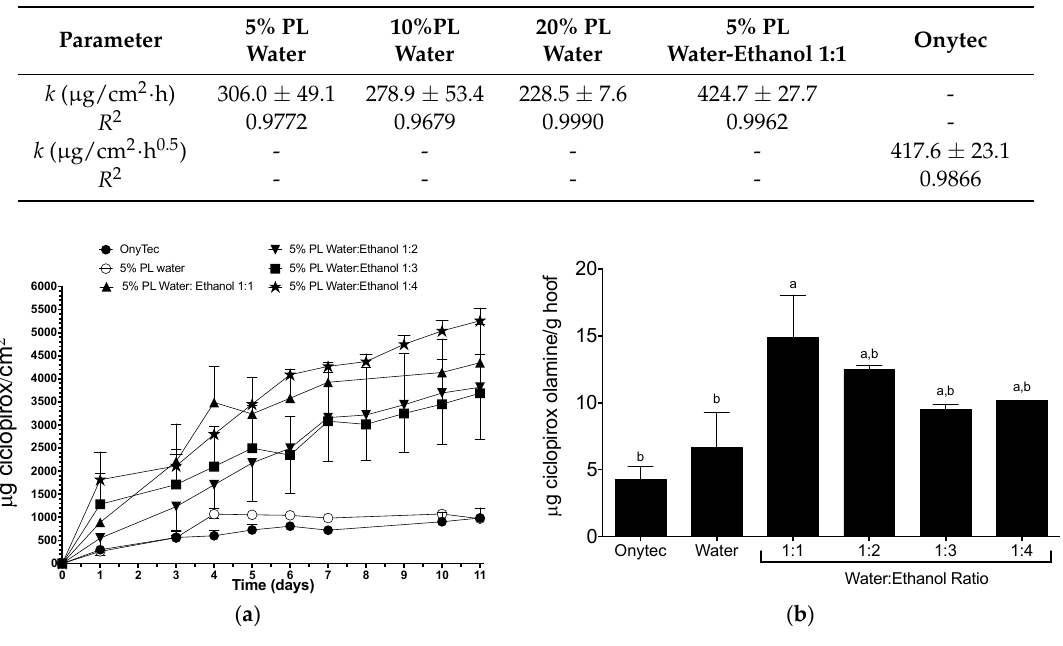
Figure 7. ( a ) Cumulative permeation (mean ± SD, n = 3) of ciclopirox olamine across bovine hoof. ( b ) amount of drug recovered from the hoof after eleven days. All the of the lacquers were made with 5% Poloxamer 407 and water:ethanol mixtures in the ratios indicate, Onytec ® (containing 8% ciclopirox) was used a reference. Same letter indicates homogeneous groups (one-way ANOVA, Tukey post-hoc test, α < 0.05).